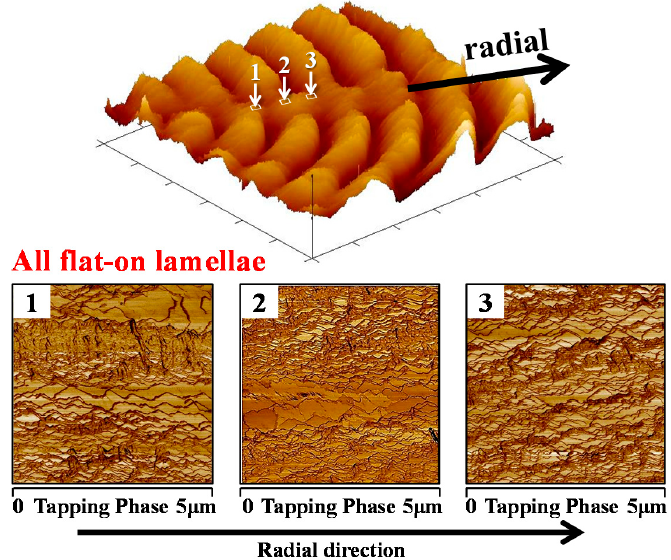
Figure 3. AFM 3D profiles and phase images on the dislocated segments in petal-like ring bands of P12T crystallized at T c = 110 °C (film thickness ~1.5–2 µm). Spots-1,2,3 indicate three different regions of the dislocated defects for zoom-in analysis.